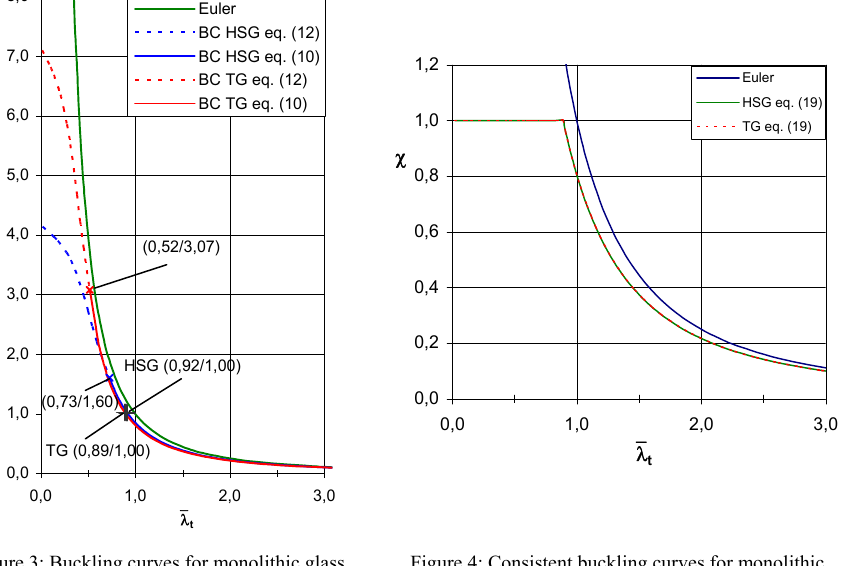
Figure 3: Buckling curves for monolithic glass columns: tempered and heat strengthened glass according to equation (10) and (12).